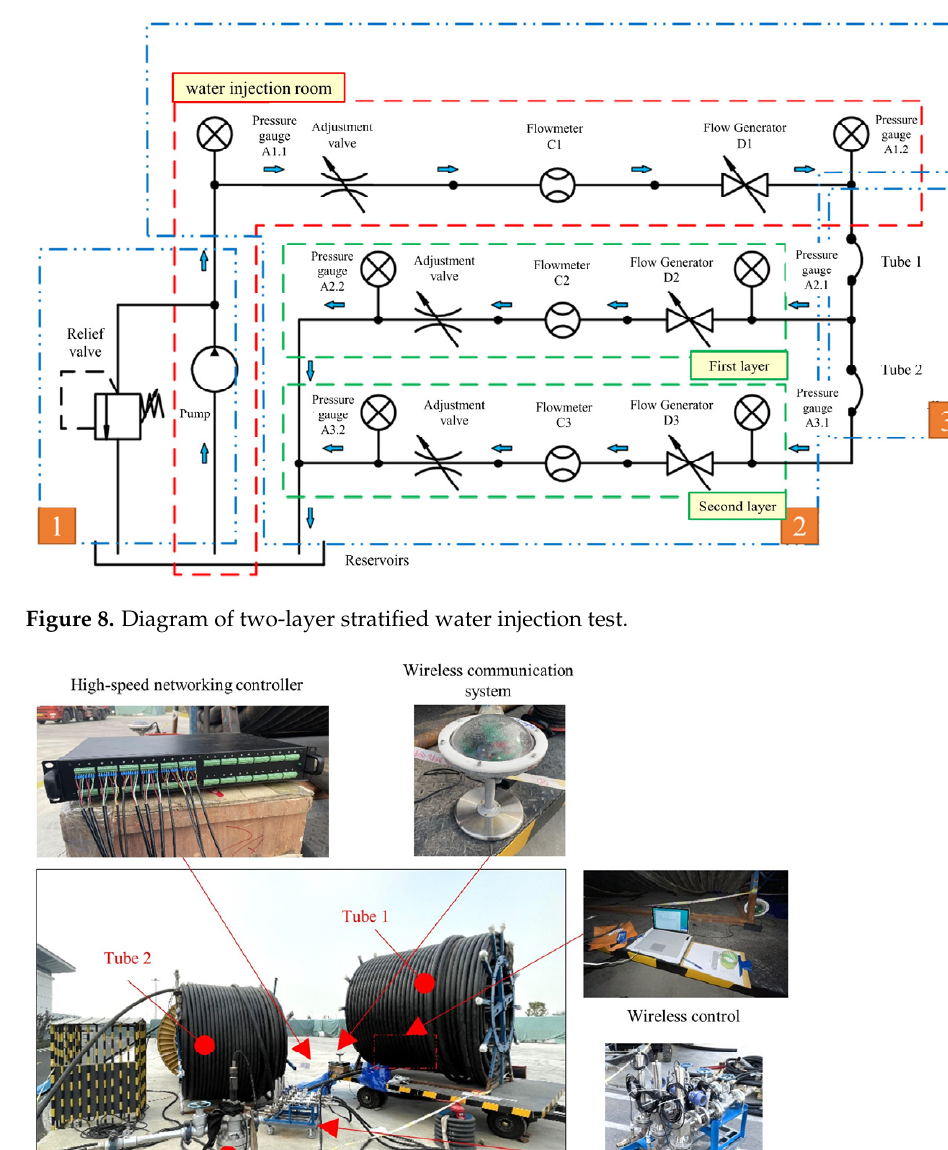
Figure 9. Two-layer stratified water injection test platform.